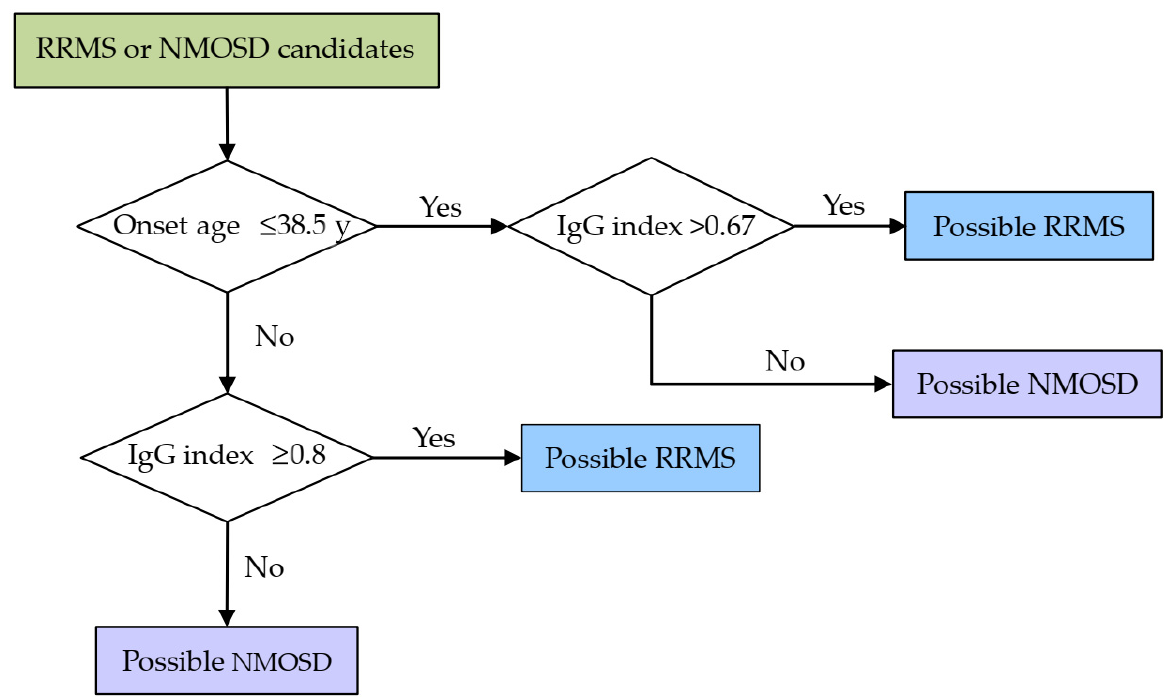
Figure 1. A two-step algorithm for discriminating between RRMS and NMOSD based on the onset age and IgG index. Abbreviations: RRMS = relapsing–remitting multiple sclerosis; NMOSD = neuromyelitis optica spectrum